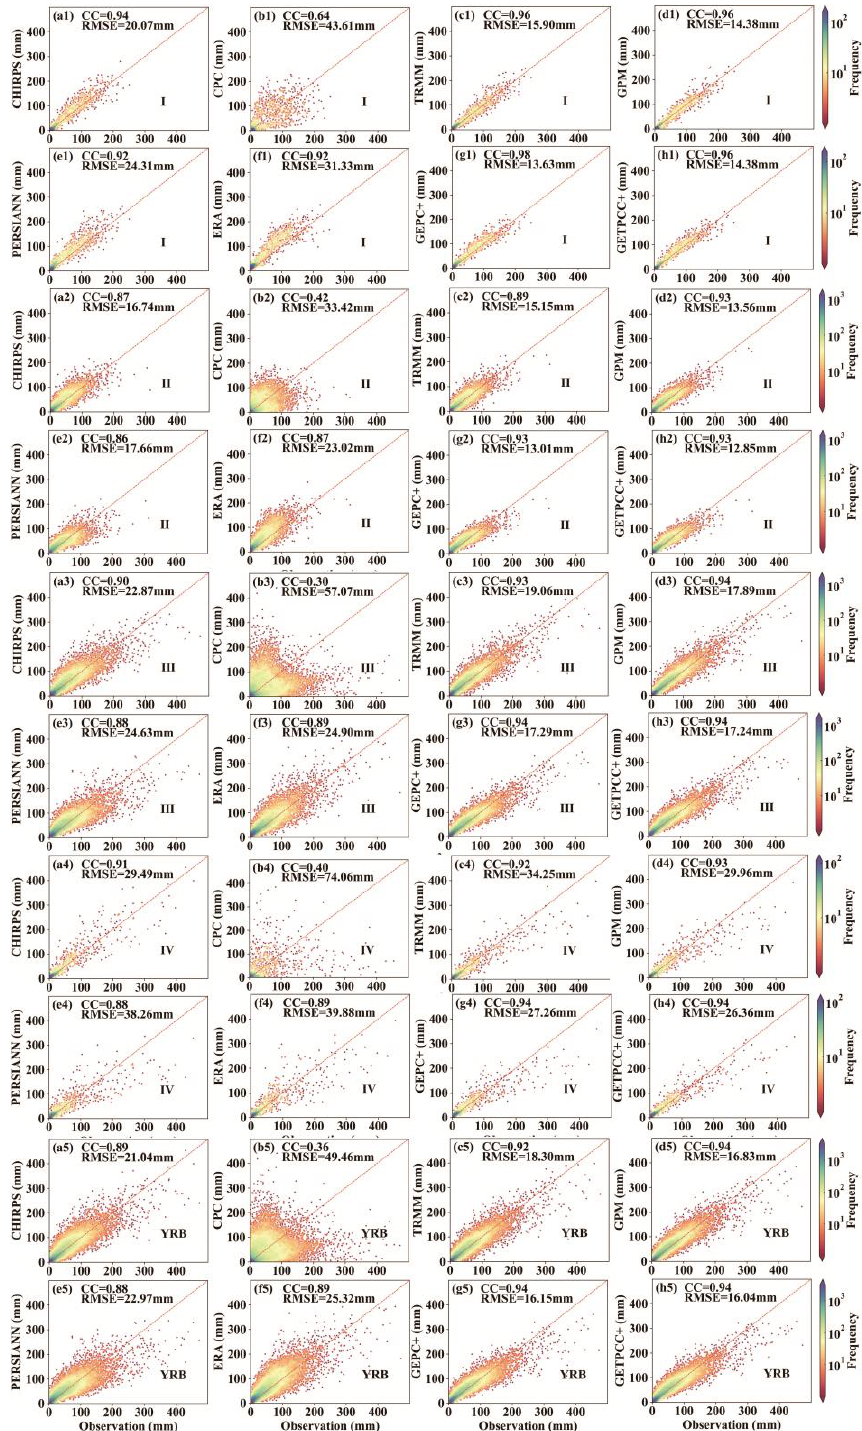
Figure 8. ( a1 – h1 ) Monthly precipitation scatter density for observations and simulations of eight precipitation products for the SRYR; ( a2 – h2 ) Monthly precipitation scatter density for observations and simulations of eight precipita-tion products for the UYRB; ( a3 – h3 ) Monthly precipitation scatter density for observations and simulations of eight precipita-tion products for the MYRB; ( a4 – h4 ) Monthly precipitation scatter density for observations and simulations of eight precipita-tion products for the DYRB; ( a5 – h5 ) Monthly precipitation scatter density for observations and simulations of eight precipita-tion products for the YRB; The legend color represents the probability density estimated using the Gaussian kernel.